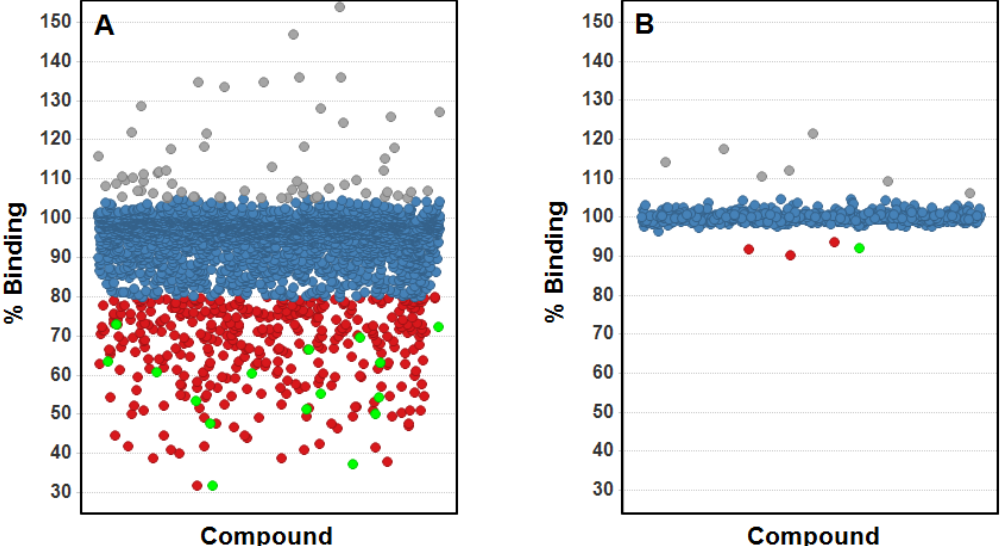
Figure 3. OWG ISA screening results on two targets with different ligandability. Activity is reported as % Binding, i.e. , the binding of the target protein to the